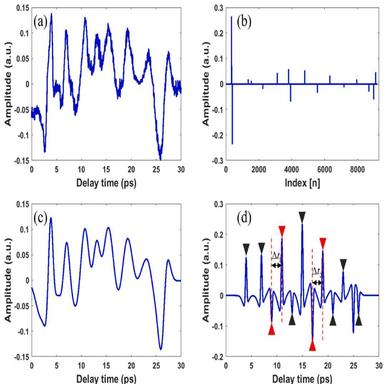
Localization results obtained by the spectrum localization strategy for the measured time-domain THz TOFT signal. (a) Measured time-domain THz TOFT signal at pixel A in Fig. 11(a). (b) Reconstructed sparse weight vector by the SBL. (c) Uncompensated THz TOFT signal by dispersive dictionary Φ′ (d) Compensated THz TOFT signal by non-dispersive dictionary Φ. The red dotted lines represent the interfaces of both delamination defects. (For interpretation of the references to colour in this figure legend, the re